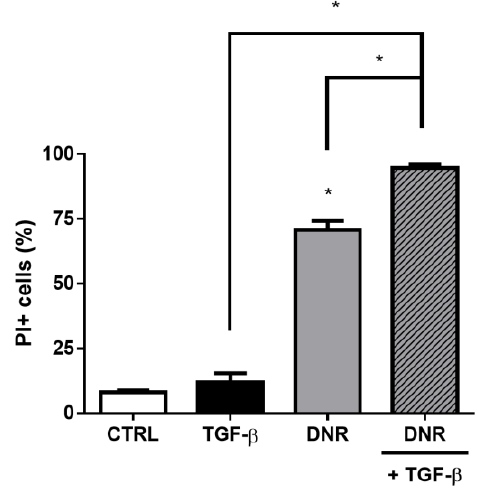
Figure 9. Daunorubincin-induced cytotoxicity increases during epithelial-mesenchymal transition (EMT). A549 cells (1 × 10 5 cells/mL) were incubated with 5 ng/mL TGF- β for EMT induction. After 48 h, cells were incubated with 500 nM daunorubicin for death induction. After, 24 h, cells were stained with propidium iodide (PI) and percentage of positive cells (non-viable cells) were evaluated by flow cytometry. Bars represent mean + SEM, and the values of significance were represented by (*) for p < 0.05 from four independent experiments.